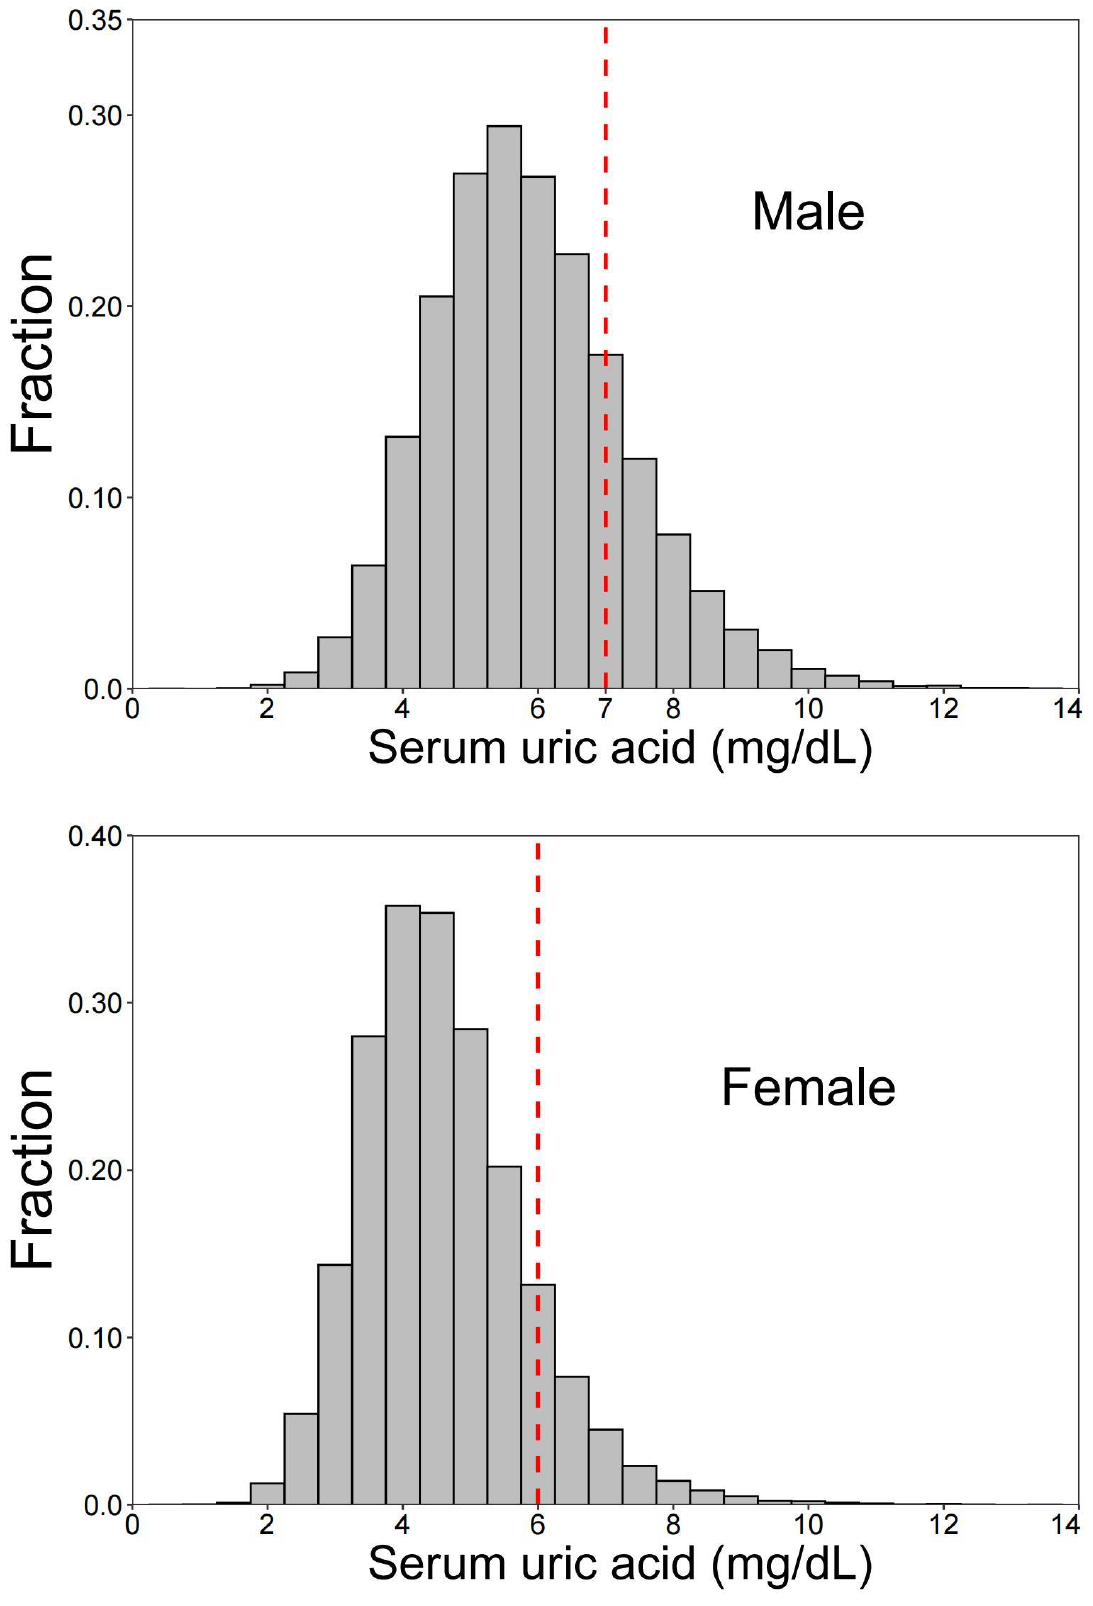
Figure 1. Distribution in serum concentrations of uric acid among 66,427 participants aged 18 years and above, CACDNS 2015. The red-dashed line indicates the cut-off values of uric acid level for hyperuricemia diagnosis, which for male is 7.0 mg/dL in men and 6.0 mg/dL in women.